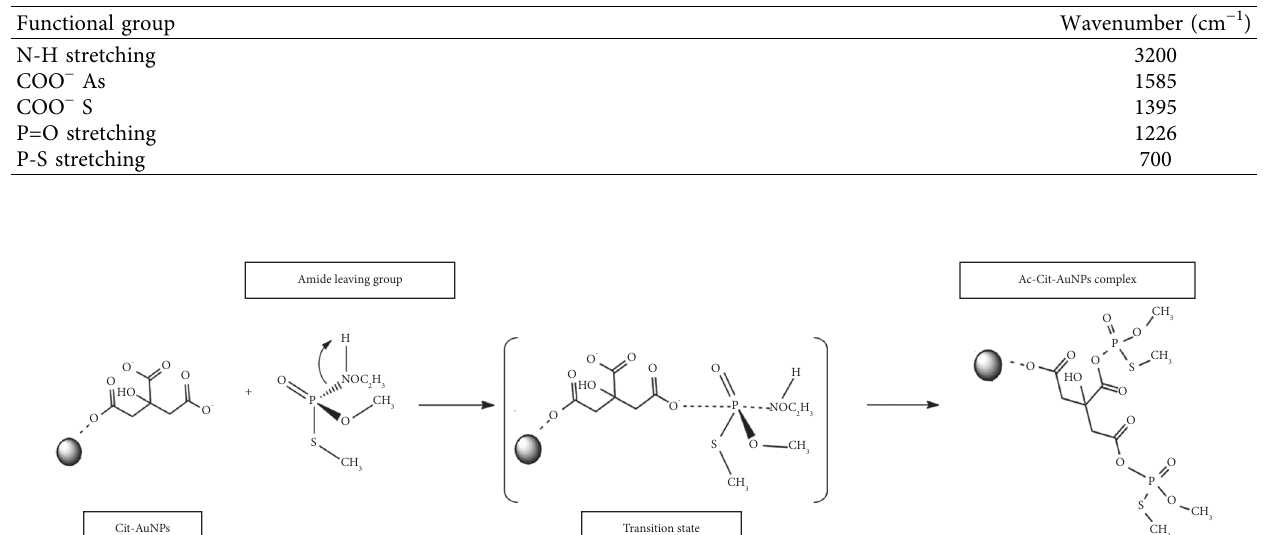
Figure 10: FTIR spectra of (a) Cit-HAuNPs, (b) Ac, and (c) Ac-Cit-HAuNPs. Table 1: Indicative FTIR peaks for Ac.